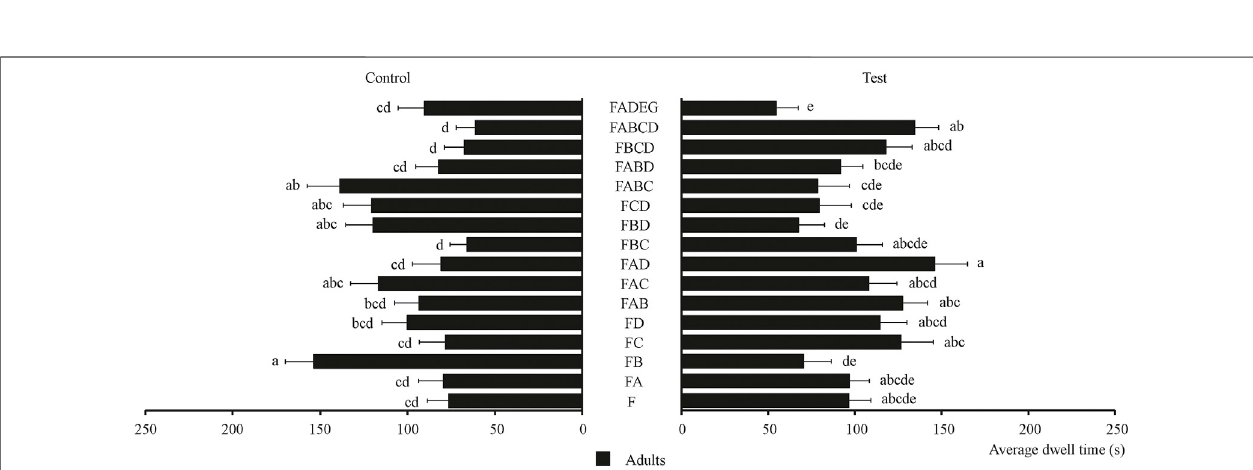
FIGURE4| Averagedwelltimeofmaleadults,femaleadults,andadultsoftobaccobeetleinthecombinationofplantessentialoilsandsexualattractants. Different lowercase letters in the fi gure represent the average dwell time of male adults, female adults, and adults of tobacco beetle with a signi fi cant difference at p < 0.05 in different combinations. Error bars shown in the fi gure represent mean ± SE.